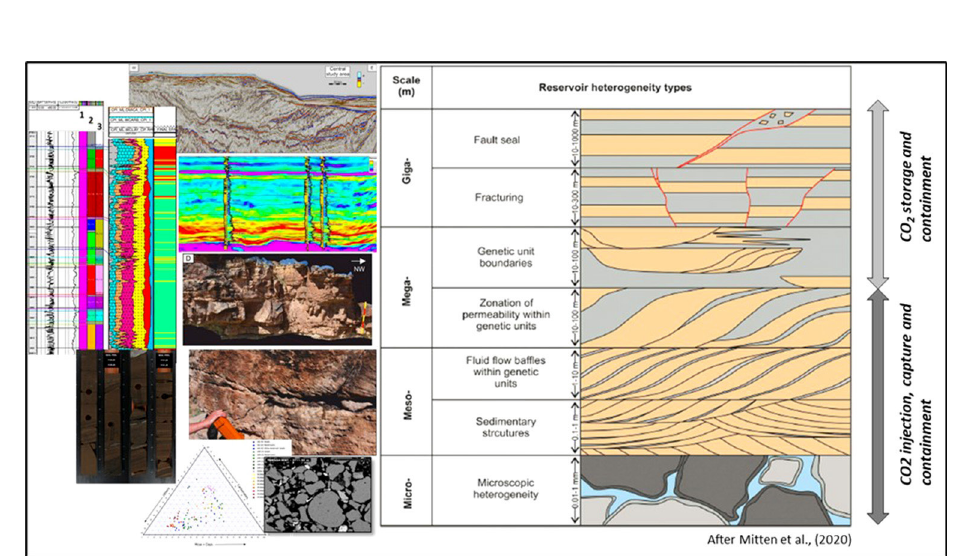
Fig. 22. – “Scale factor” in subsurface characterization. Different data are used at different